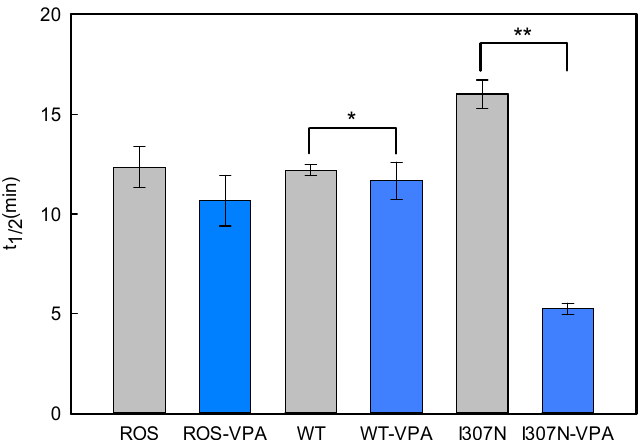
Figure 6. Fluorescence Meta II Decay: The t 1/2 for the retinal decrease that closely parallels de Meta II decay process under our experimental conditions was determined from experimental results depicted in Figure 4. The t 1/2 values for immunopurified ROS, WT, and I307N mutant, with (dark blue) and without VPA treatment (grey), are reported. The mean value and standard error (SE) were obtained from independent purifications ( n = 3). Treatment with VPA does not cause a significant effect on the active conformation stability of WT Rho (*) but a statistically significant decrease in the stability of the Meta II conformation of the I307N mutant (**) ( p <